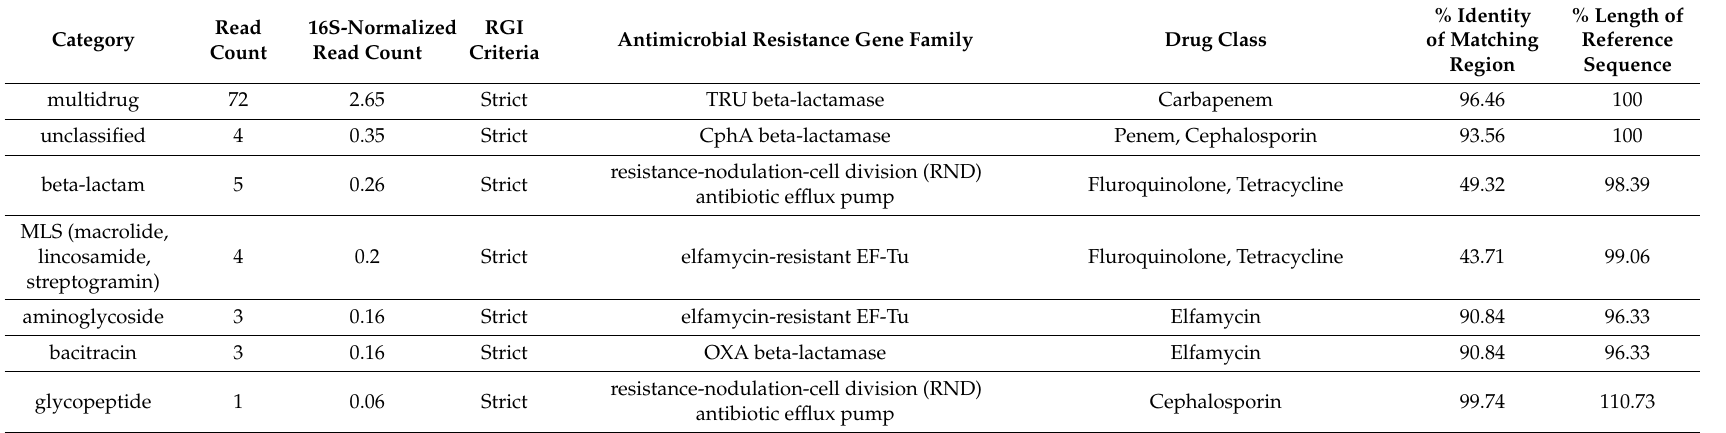
Table 2. Resistance Gene Identifier (RGI) analysis for A. hydrophila .